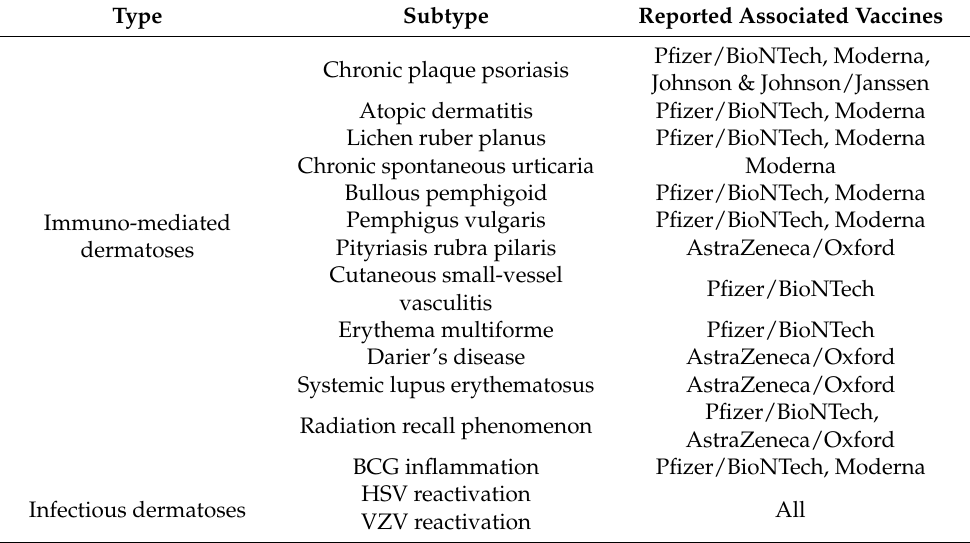
Table 2. Preexisting dermatoses flared by the SARS-CoV-2